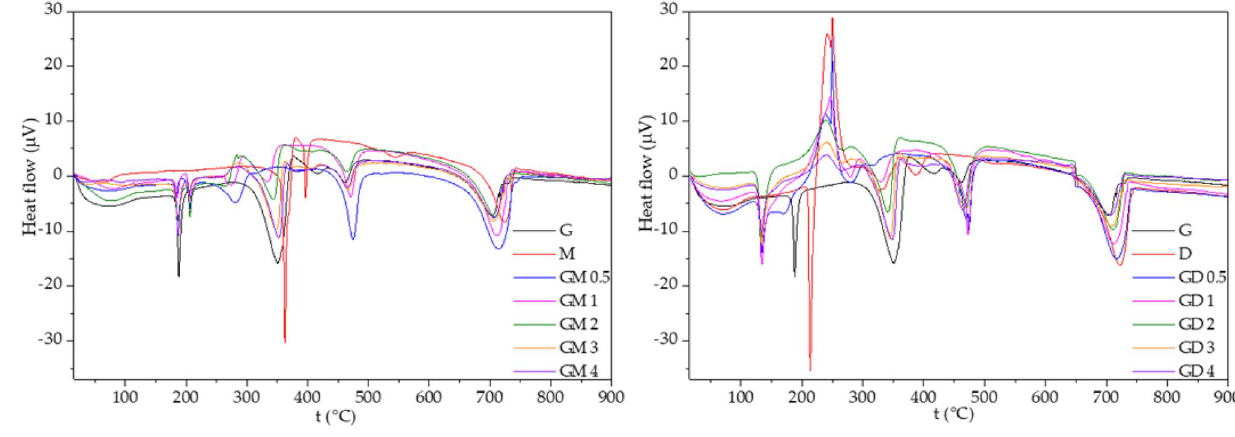
Figure 13. DSC curves of CN materials.